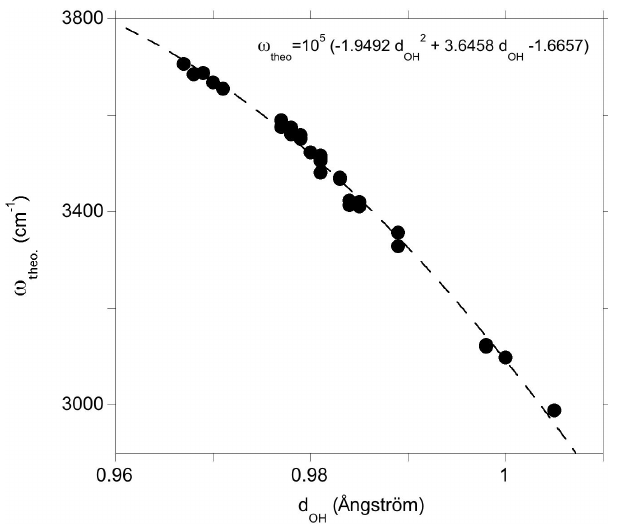
Figure 5. Theoretical OH-stretching frequency ( ω theo ) as a func- tion of the O–H distance ( d OH ). The dotted line corresponds to a quadratic fit of the data serving as a guide for the eye.